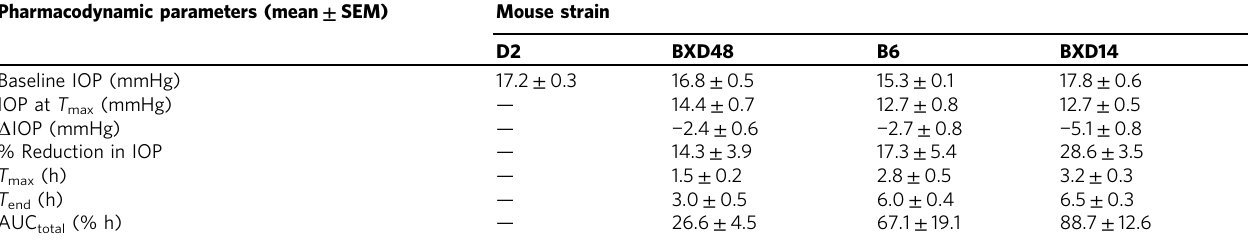
Table 2 Pharmacodynamic parameters after application of 0.9% pregabalin eye drops to D2, BXD48 ( D allele), B6, and BXD14 ( B allele) mice